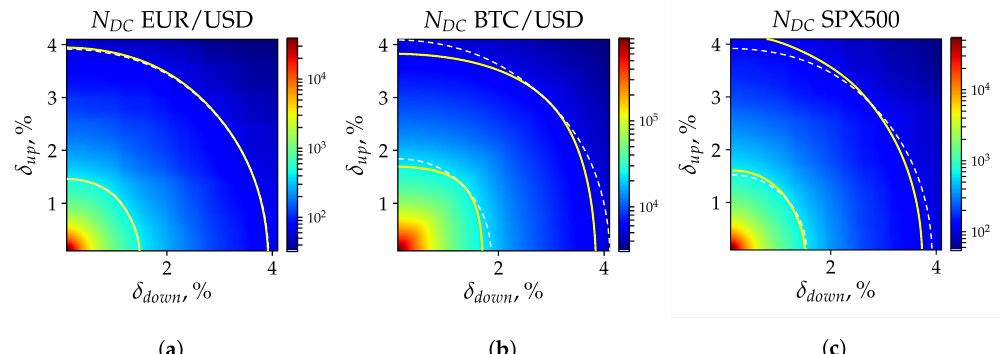
Figure 3. Heat map of the number of directional changes calculated in ( a ) EUR/USD, ( b ) BTC/USD, and ( c ) SPX500 time series. Each point on the grid represents the number of directional changes δ up , δ down registered by a unique pair of thresholds . Heatmaps have different scales. Yellow solid { } lines, specific for each heatmap, label the examples of the areas along which the number of intrinsic events is constant. The dashed lines represent the theoretical areas of the equal number of intrinsic events observed in case of the trend-less time series. White dashed lines are parts of circles centred around the left bottom corner of each picture. The lines go through the intersection of the solid yellow lines and the diagonal of each